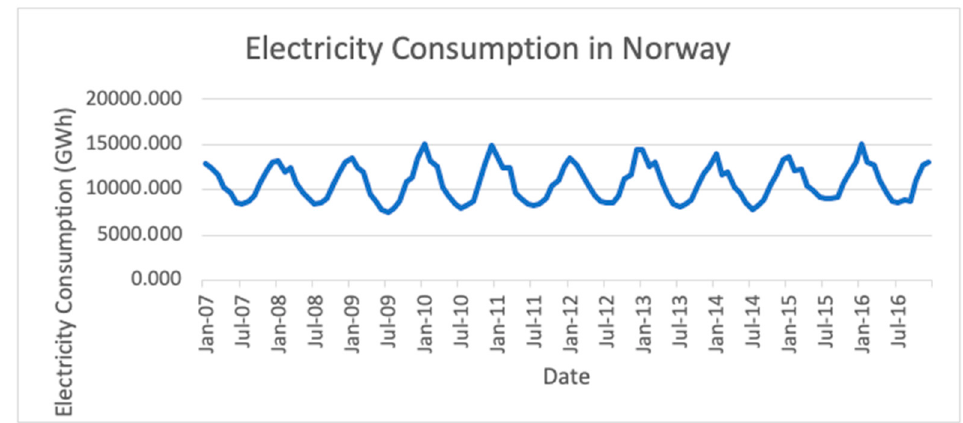
Figure 5. Electricity consumption in Norway from 2007 to 2016.